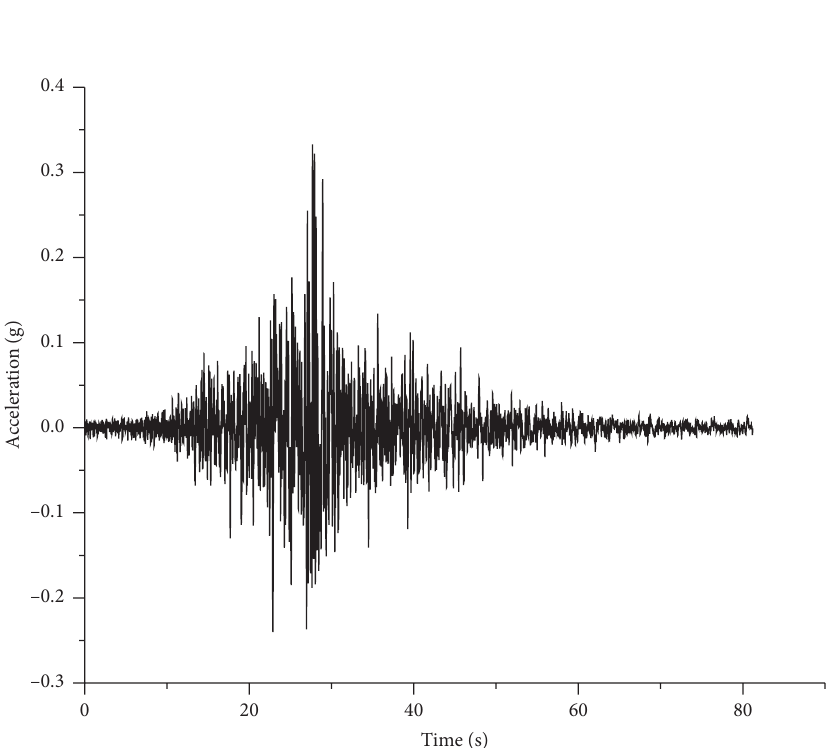
Figure 4: Seismic wave two: san-ew